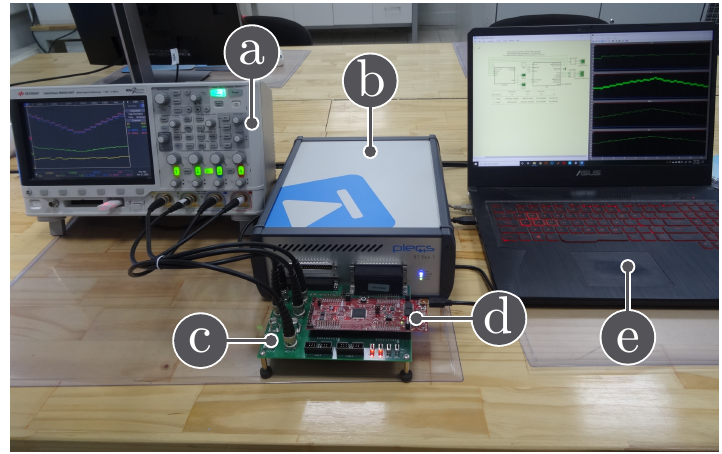
Figure 3. Hardware in-the-loop experimental setup: (a) oscilloscope, (b) PLECS RT box, (c) RT box launchPad interface, (d) Texas Instruments LAUNCHXL-F28069M, (e)